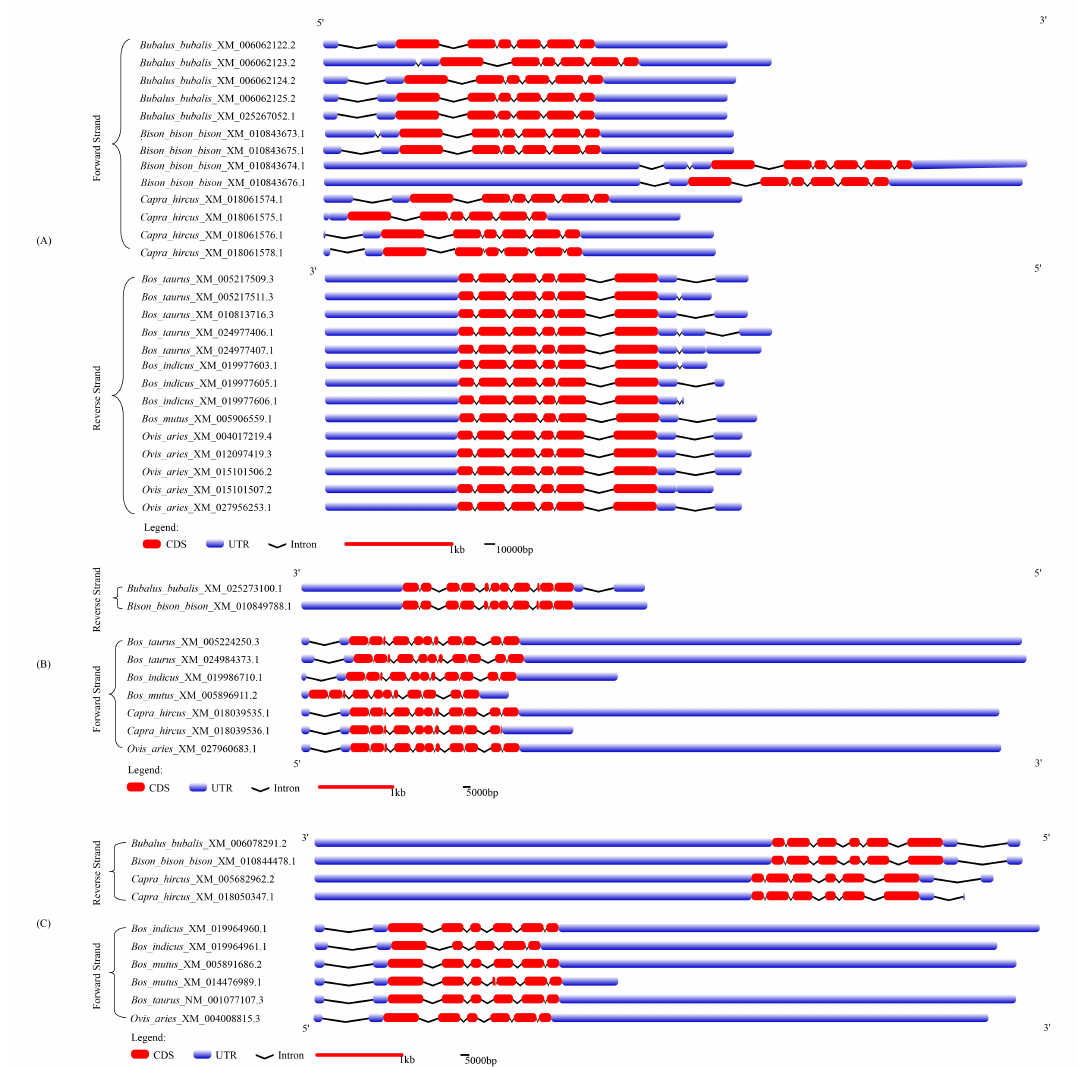
Figure 3. The gene structure of Smads 1 , 4 , and 5 . ( A ) Smad1 , ( B ) Smad4 , ( C ) Smad5 . The red boxes, blue boxes, and the black hat lines represented untranslated regions (UTRs), CDSs, and introns. The length of the exon and intron can be inferred from the legend at the bottom.